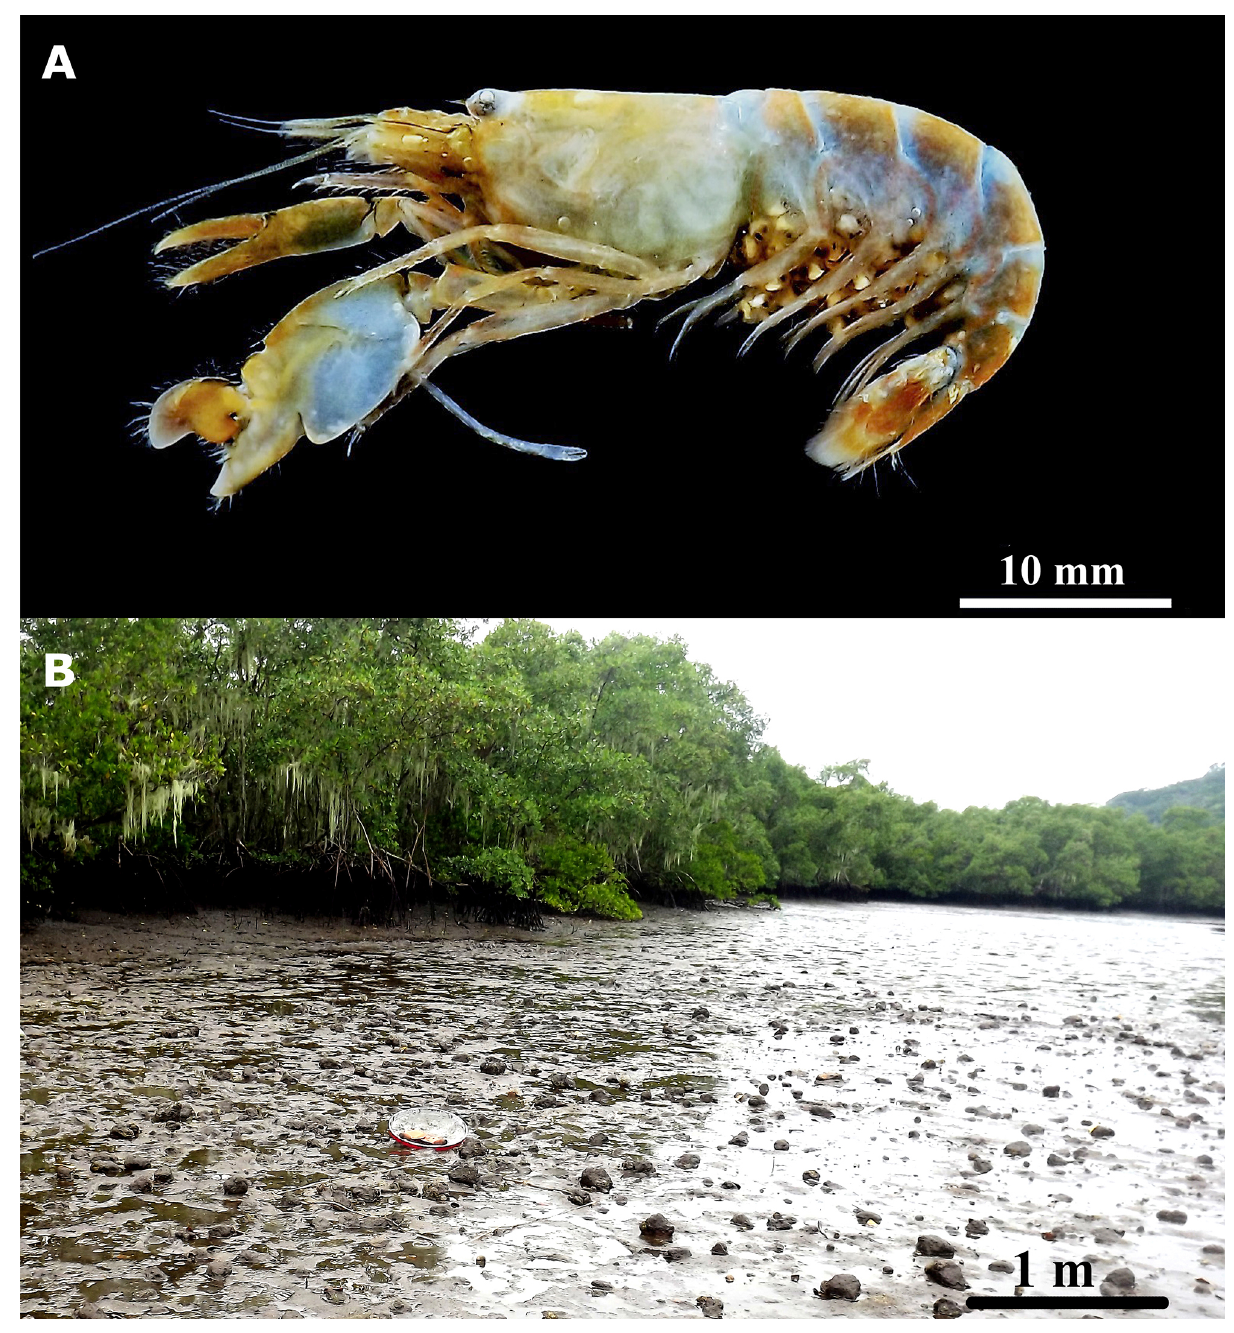
Figure 2. A, Lateral view of an ovigerous female of Alpheus brasileiro Anker, 2012; B, sampling area at the intertidal zone of the estuary of Cananéia, São Paulo, south–eastern